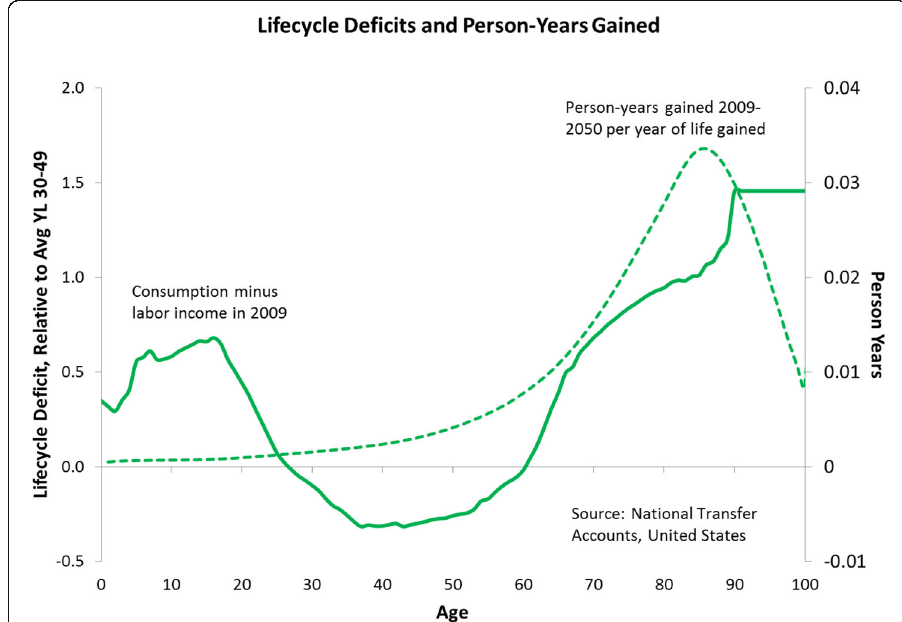
Fig. 8 How mortality decline affects labor, leisure, and consumption. Note: Person years gained is the Lx function in 2050 minus that in 2009. The LCD is for the USA in 2009. Survey data truncated above age 90. Source: US mortality data from the Human Mortality Database. Consumption minus labor income from National Transfer Accounts for